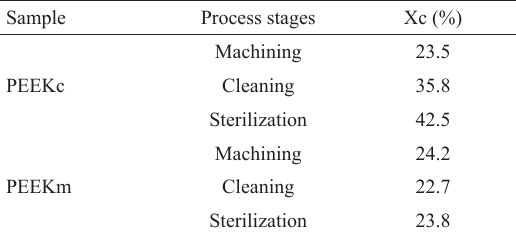
Table 2: Crystallinity index (Xc) for PEEKc and PEEKm calculated by DSC after machining, hygienization and sterilization process